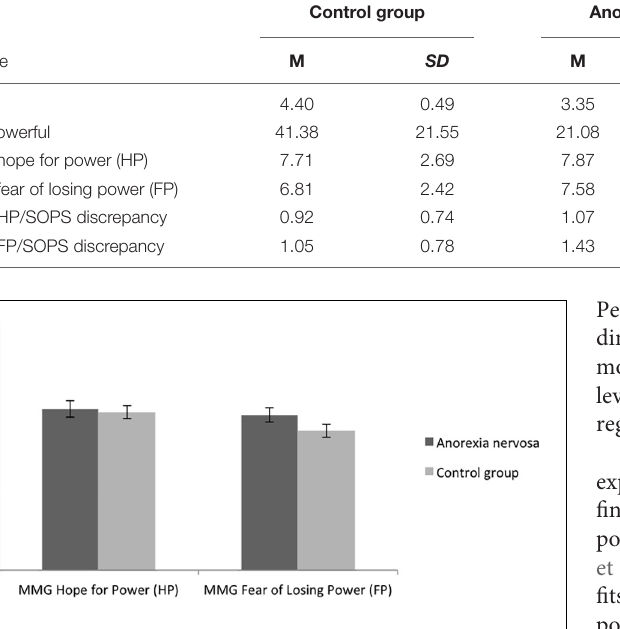
FIGURE 3 | Means of the Multi-Motive Grid (MMG) fear of losing power and hope for power dimension of women with and without AN. Error bars represent